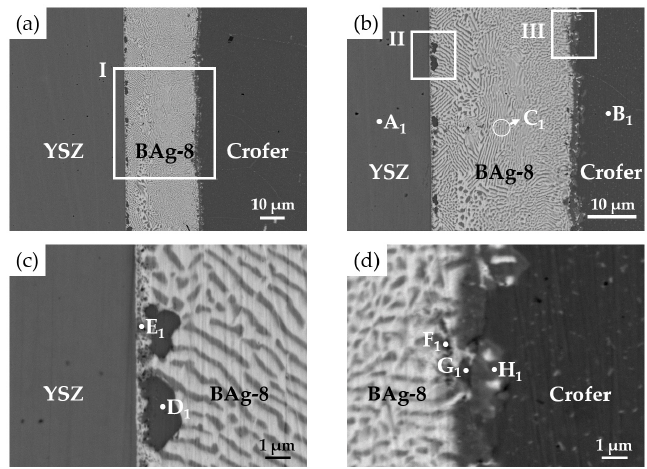
Figure 3. EPMA BEIs of the BJ-1 vacuum brazed at 850 °C for 600 s: ( a ) Cross section of the joint, ( b ) higher magnification of area I in ( a ), ( c ) YSZ side of area II in ( b ), and ( d ) Crofer side of area III in ( b ).